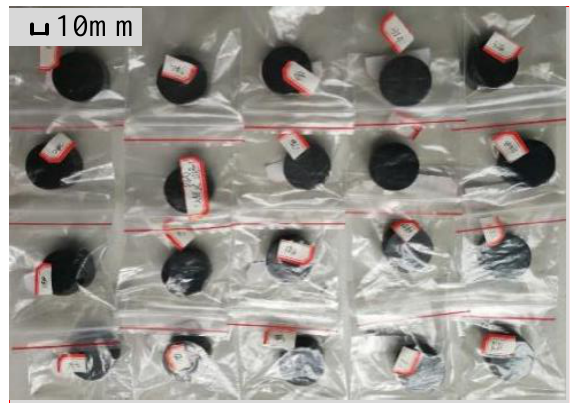
Figure 2. Rubber samples for quasi-static compression loading.